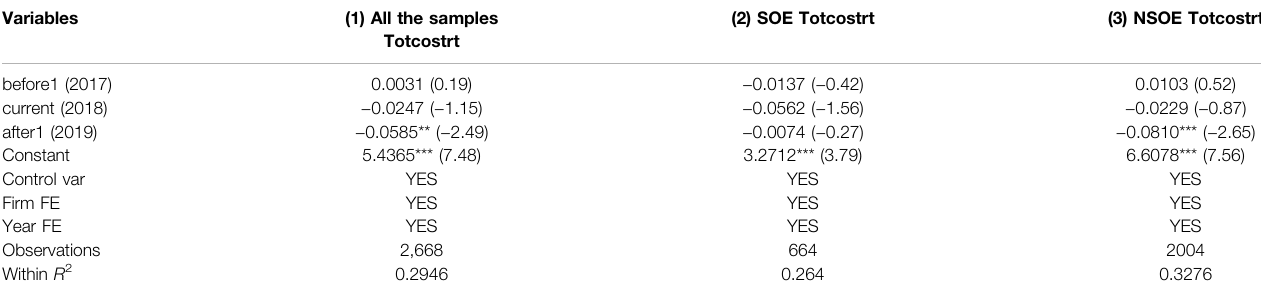
TABLE 4 | Common trend test results.